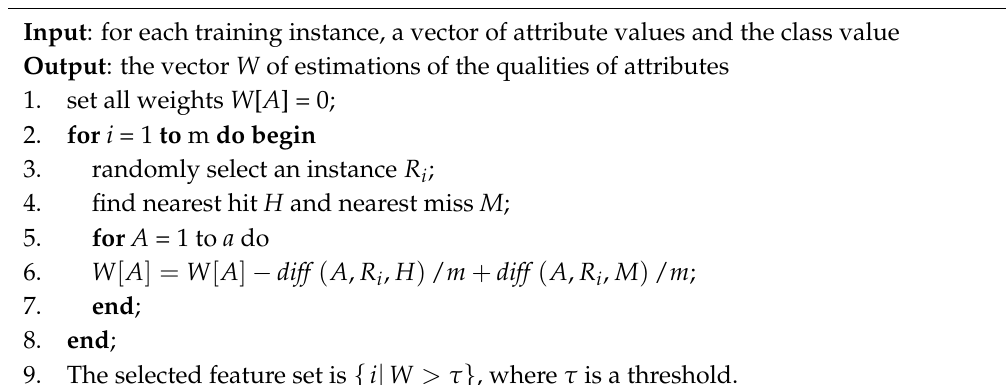
Algorithm 1. Pseudo-code of the RELIEF